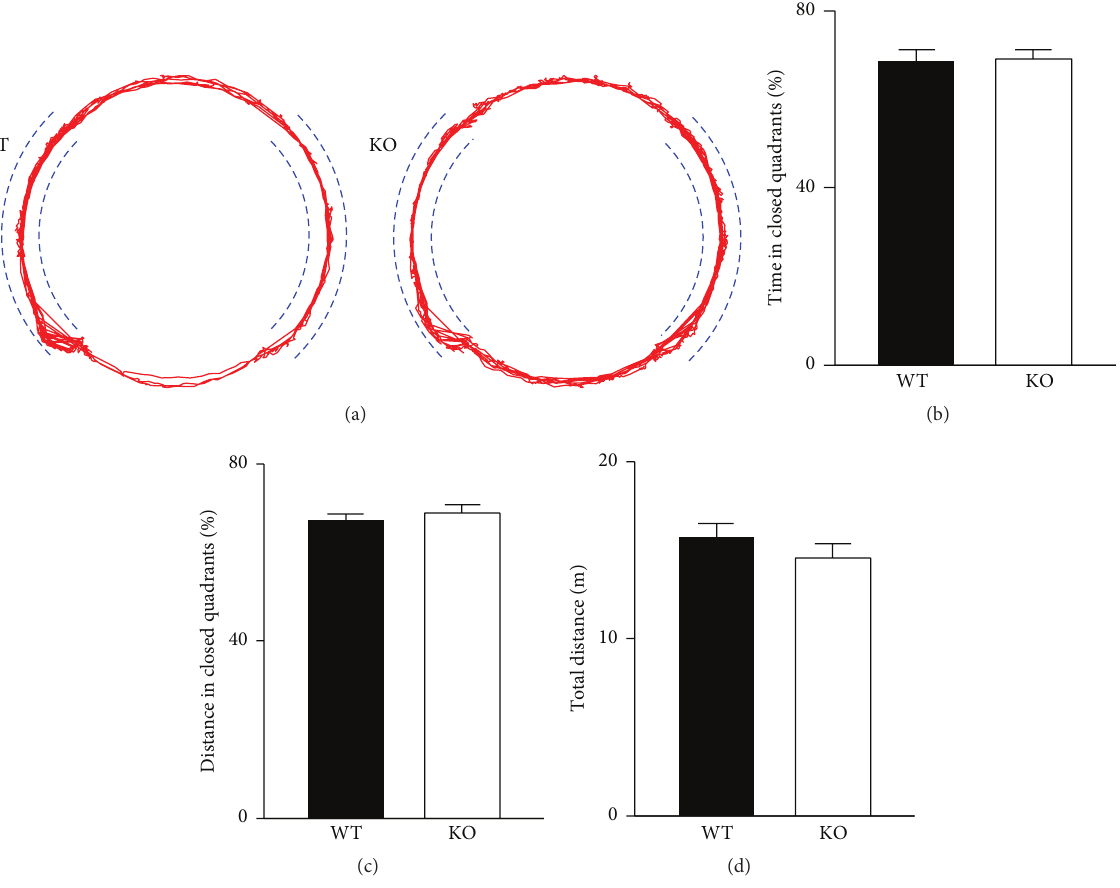
Figure 4: The anxiety level of CB2R KO mice is similar to that of WT mice when assayed in an elevated zero maze. (a) Representative tracking of mice in an elevated zero maze for 5 min. Dashed lines indicate the walls in two closed quadrants. (b-c) KO and WT mice spent similar time (b) and traveled similar distances (c) in the closed quadrants of the zero maze. (d) The total travel distance of KO mice in the zero maze for 5 min was not significantly different from that of WT mice. Error bars represent SEM.